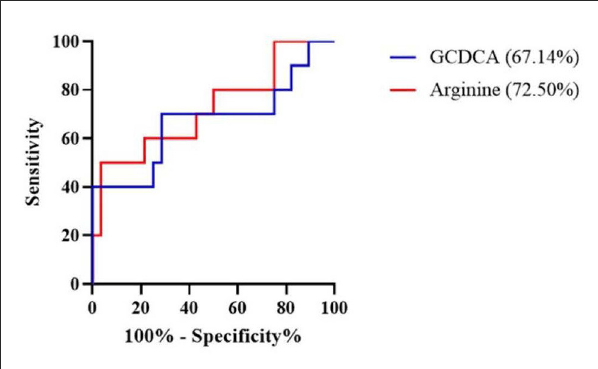
FIGURE4 Receiver operating characteristic (ROC) curve revealed candidate biomarkers for predicting AECOPD. AECOPD, acute exacerbation of chronic obstructive pulmonary disease; GCDCA, glycochenodeoxycholic